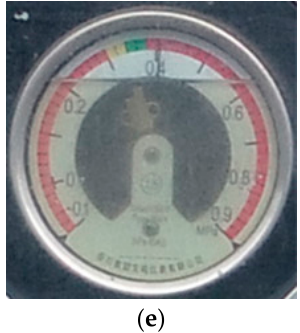
Figure 3. Five kinds of meters. ( a ) bj, which refers to oil level, ( b ) bjA, which refers to Sulfur Hexafluoride Density Relay, ( c ) bjB, which refers to Discharge Counter With Current Meter For Arrester, ( d ) bjH, which refers to Discharge Counter and ( e ) bjL, which also is Sulfur Hexafluoride Density Relay.